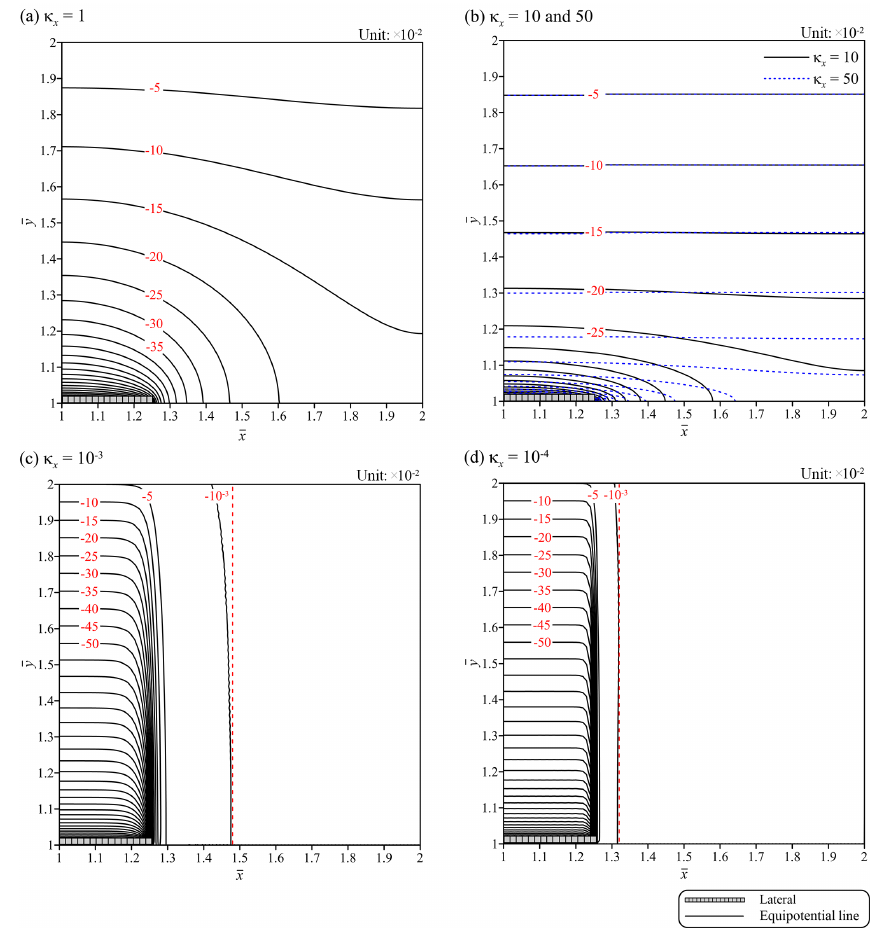
Figure 3. Spatial distributions of the dimensionless head predicted by the present head solution for κ x = (a) 1, (b) 10 and 50, (c) 10 − 3 and (d) 10 − 4